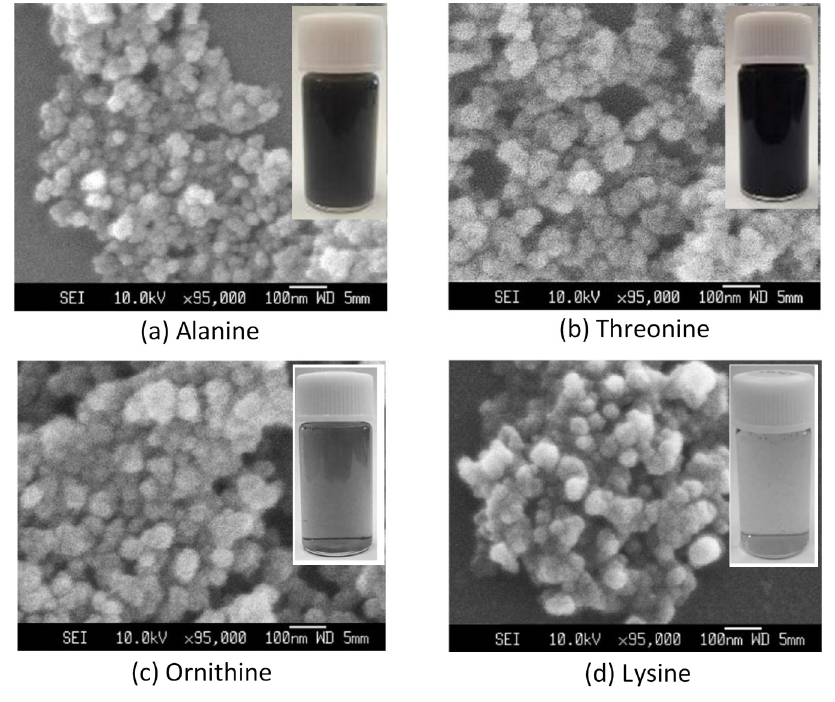
Figure 10. TEM image of the nanoparticle products formed using pulsed discharge plasma ( a ) and their magnification ( b ) [40].